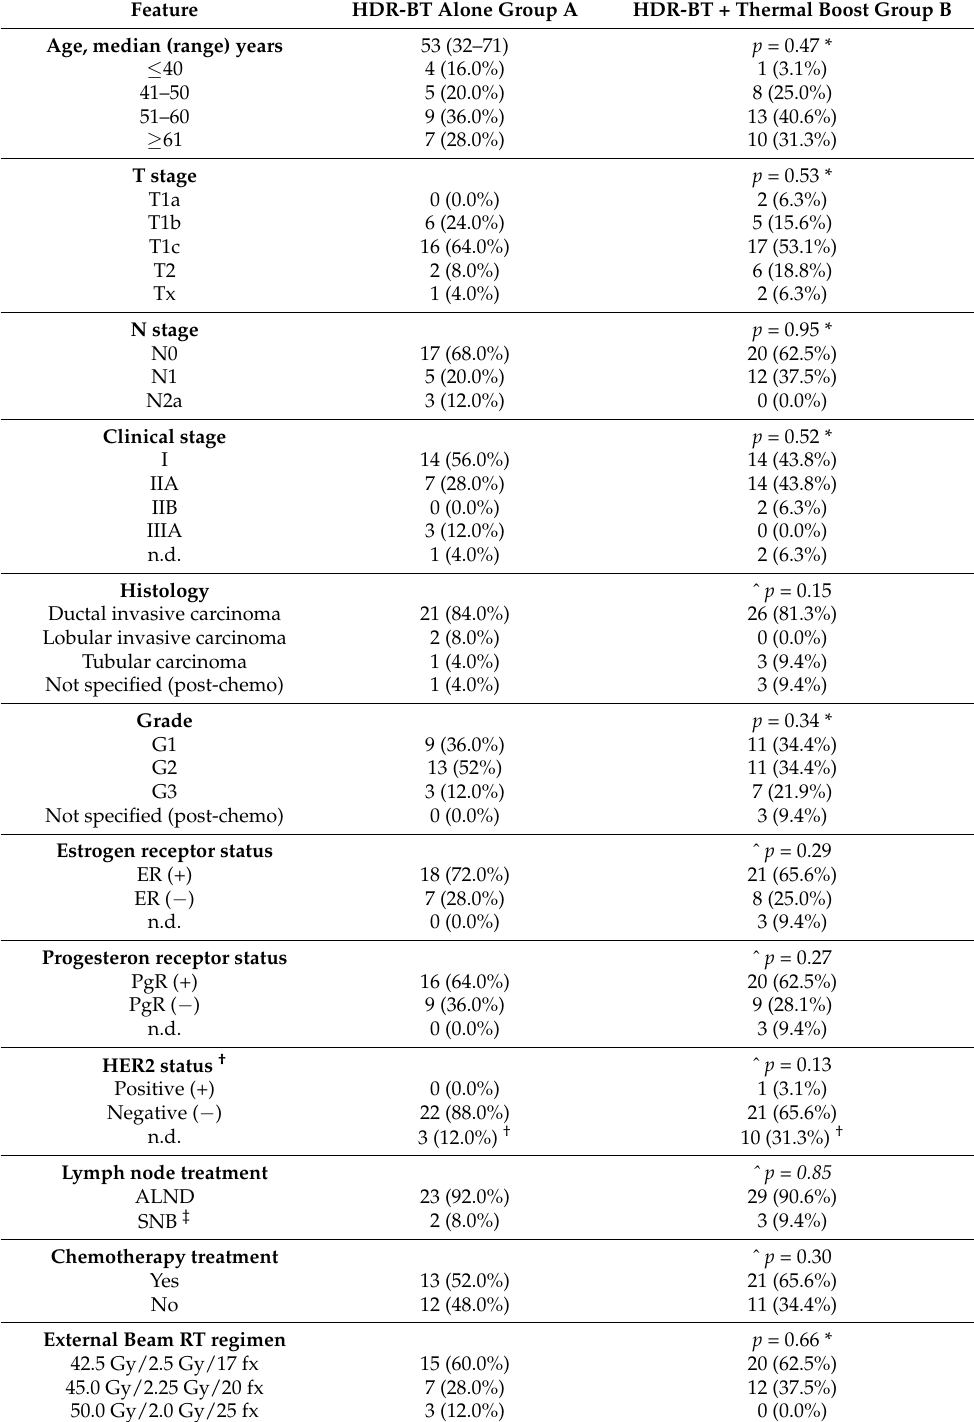
Table 1. Patient and tumor clinical